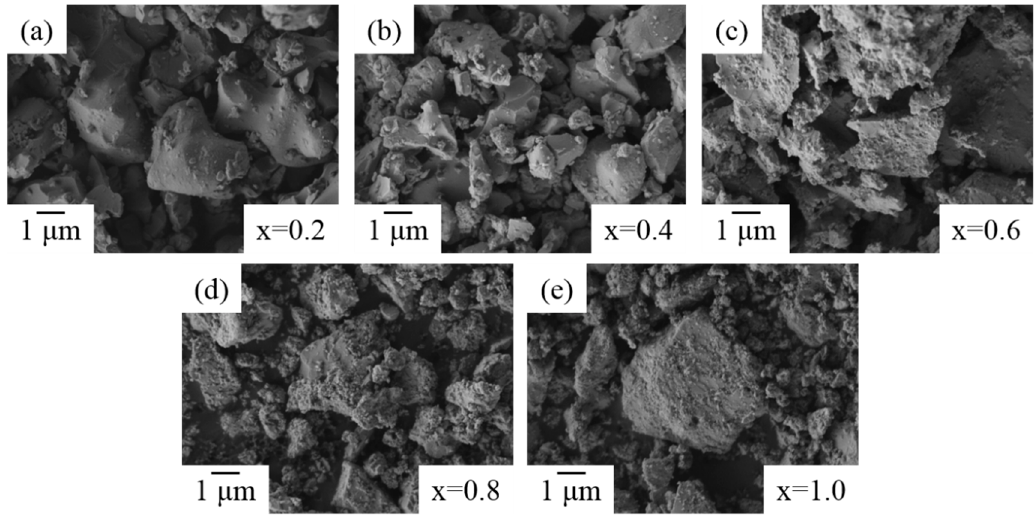
Figure 8. SEM images of Bi 2 − x Zr x O 3+x/2 powders after 750 °C heat treatment at: ( a ) x = 0.2; ( b ) x = 0.4; ( c ) x = 0.6; ( d ) x = 0.8; and ( e ) x = 1.0.